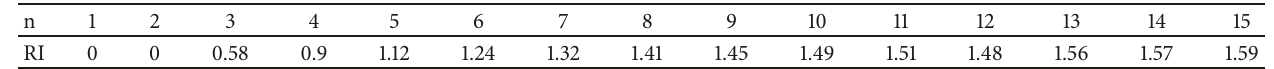
Figure 10: Graphical sensitivity analysis for criterion F1. Table 6: Random Consistency Index